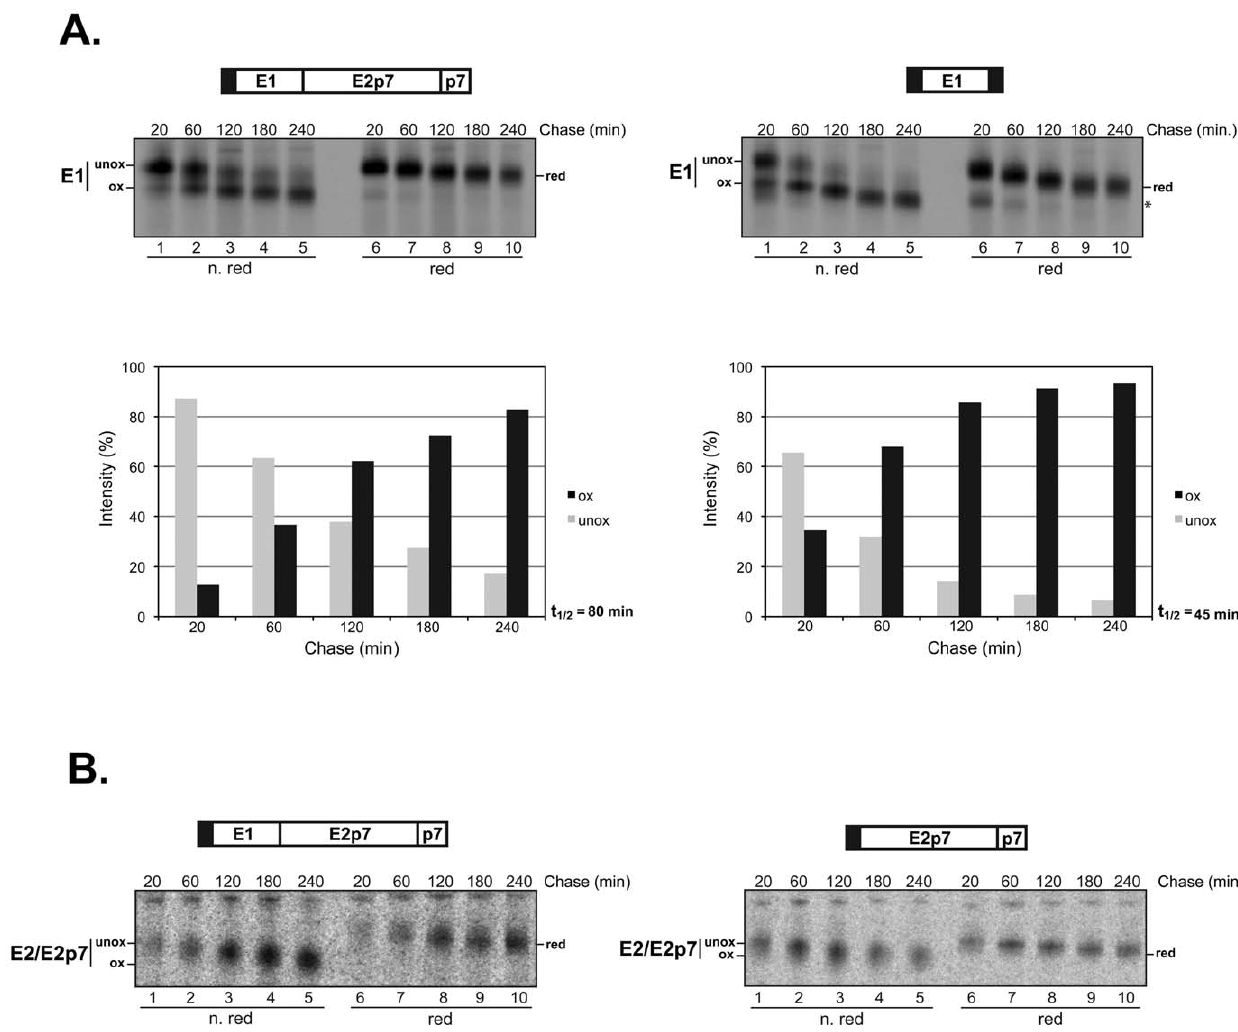
Figure 2. Oxidation kinetics of E1 and E2p7 HCV glycoprotein. CHO cells stably transfected with constructs expressing E1, E2p7 or E1E2p7 were pulse-labeled with [ 35 S]-methionine and -cysteine for 20 min and chased for the indicated time-periods. PNSs were immunoprecipitated with (A) CBH-111 anti-E1 monoclonal antibody or (B) CBH-7 anti-E2 monoclonal antibody. Samples were analyzed on 10% SDS-PAGE in non-reducing (lanes 1–5) and reducing (lanes 6–10) conditions. For E1, the relative intensity of the unoxidized (grey bars) and oxidized (black bars) forms were quantified for the different chase-times. The E1E2p7 wild type species is reported on the left graph, E1 alone on the right graph. The half-time (t 1/2 ) of E1 oxidation represents the chase-time at which half of the protein is in its oxidized form. Symbols refer to: ox for oxidized; unox for unoxidized; red for reduced.